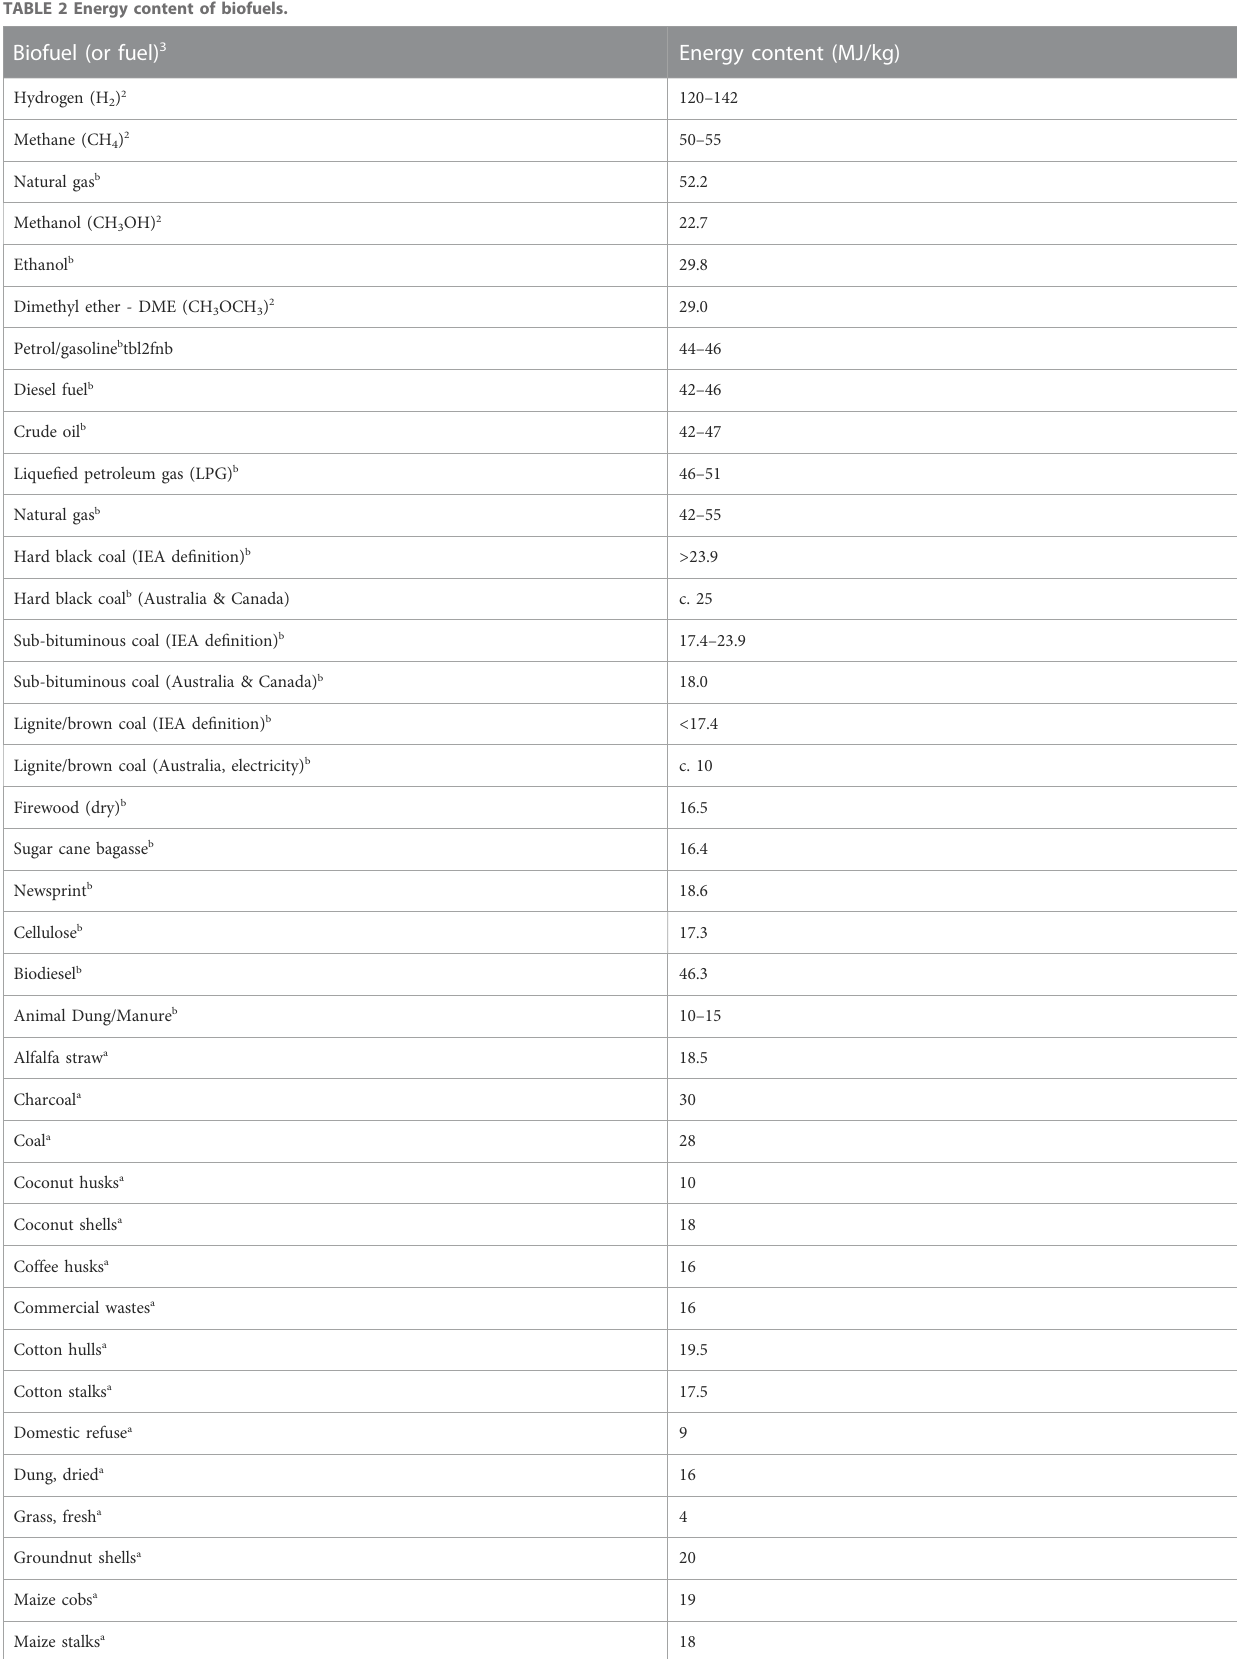
TABLE 2 Energy content of